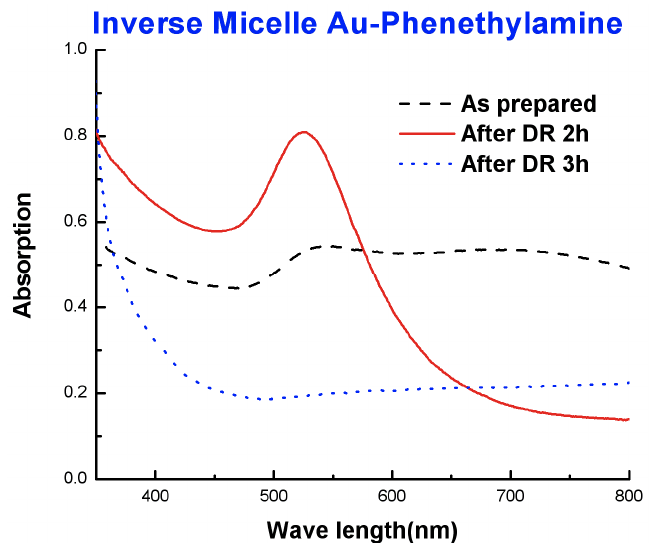
Figure 22. UV-visible spectrum of Au-phenethylamine colloids before and after digestive